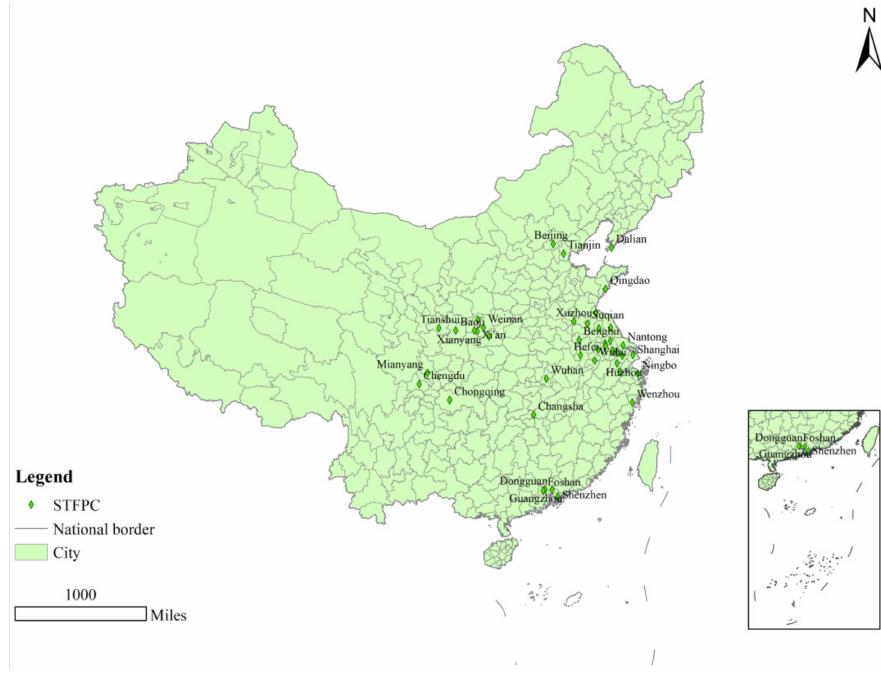
Figure 2. The distribution of science and technology finance pilot cities in